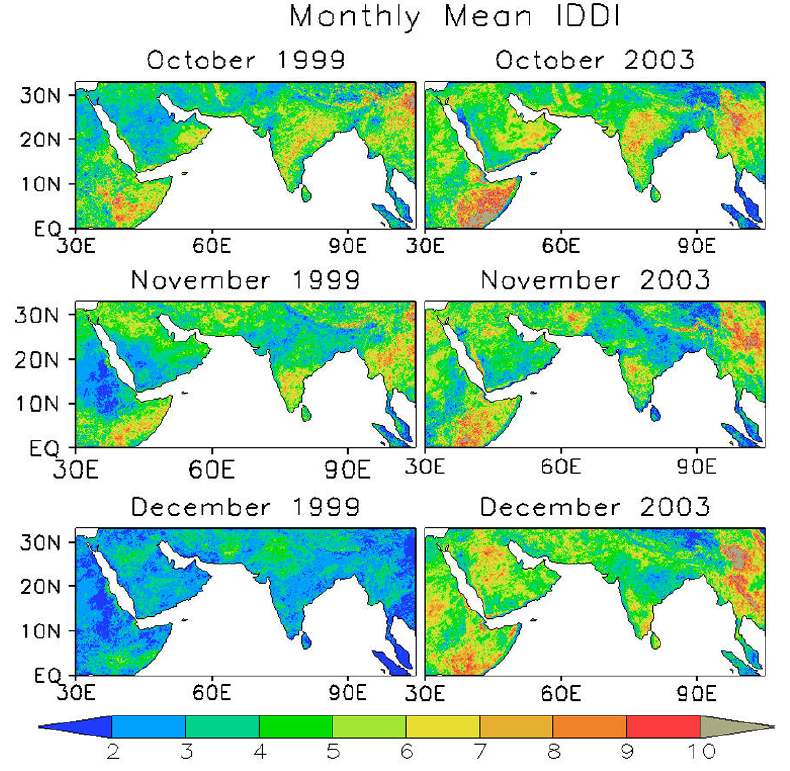
Fig. 26. Regional distribution of IDDI (K) for October, November and December (1999 and